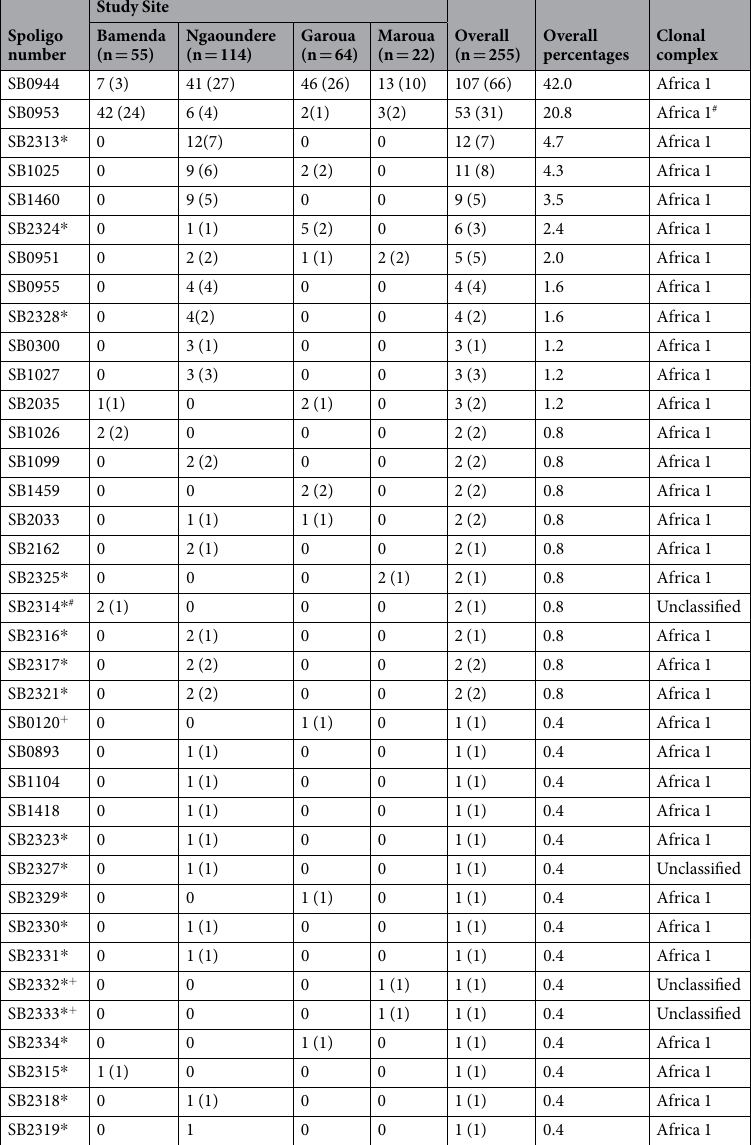
Table 2. Distribution of spoligotypes of M. bovis recovered from cultured cattle lymph nodes from four abattoirs in Cameroon between 2012–1013. Spoligotype count per animal by abattoir is given in parentheses. * Novel i.e. previoulsy unreported spoligtypes, + The Africa 1 defining spacer 30 is intact, # This sample gave mixed results therefore could not be conclusively assigned to a clonal complex, Unclassified means that the spoligotype does not belong to any of the currently known clonal complex